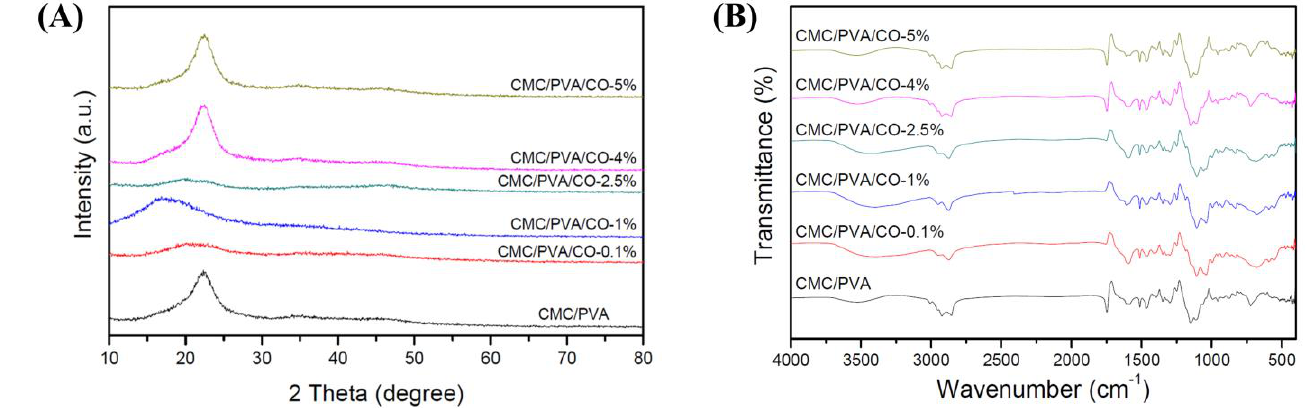
Figure 3. ( A ) XRD patterns and ( B ) FTIR spectra of the CMC/PVA/CO composite films with different concentrations of CO (0.0%, 0.1%, 1%, 2.5%, 4%, and 5%).